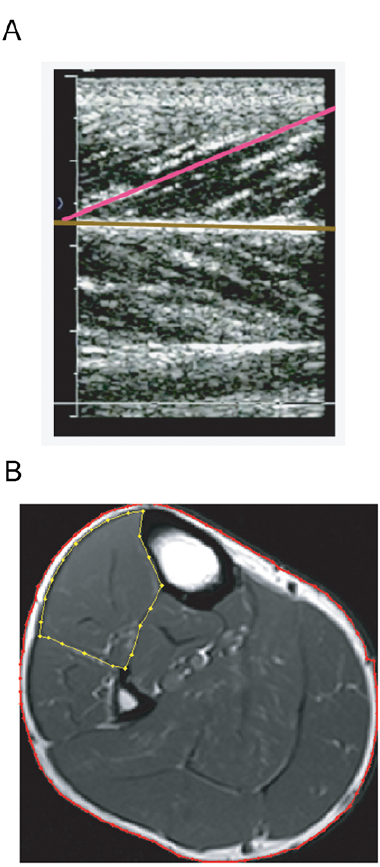
Figure 3. In vivo Muscle Imaging. A: Ultrasound image of the anterior compartment of the lower limb. The horizontal line matches the orientation of the apponeurosis of the tibialis anterior muscle, and the angled line matches the pennation angle of visible fascicles under the ultrasound probe. B : Magnetic Resonance Image (MRI) in the Axial Plane. The dotted line represents the region of interest (ROI) for subsequent analysis of anterior compartment muscle size.